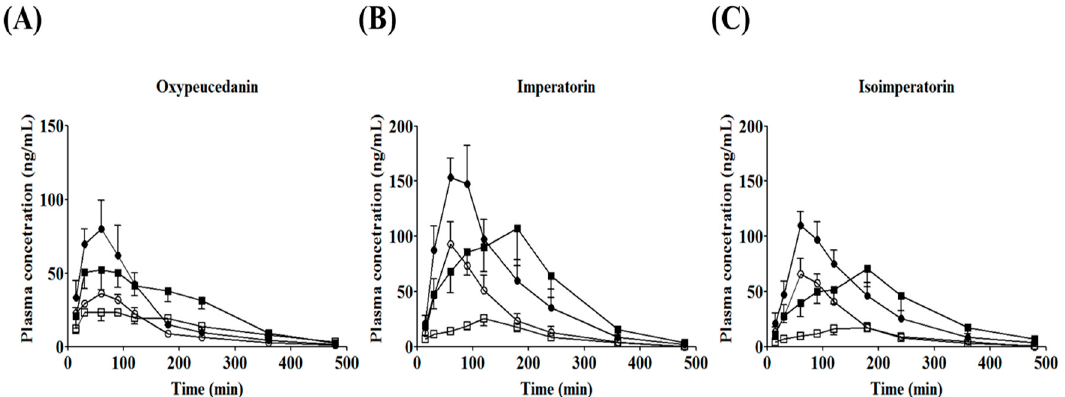
Figure 4. Plasma concentration–time curves of oxypeucedanin ( A ); imperatorin ( B ); and isoimperatorin ( C ) after oral administration of Angelica dahurica Radix (ADR, 0.5 and 1.0 g/kg, open and closed symbols, respectively) to normal (circle) and experimental colitis (square)-induced rats. Table 5. Pharmacokinetic parameters of oxypeucedanin, imperatorin, and isoimperatorin after oral administration of Angelica dahurica Radix to normal and experimental TNBS-treated rats.